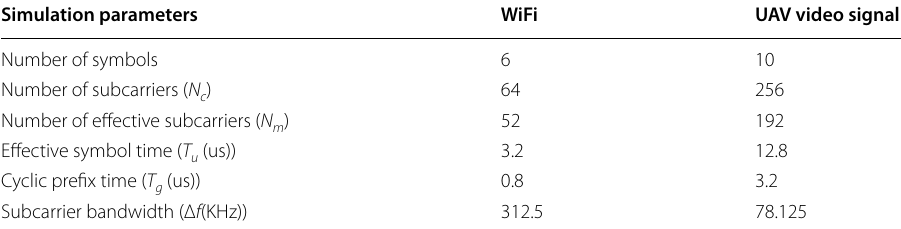
Table 1 Simulation parameters Simulation